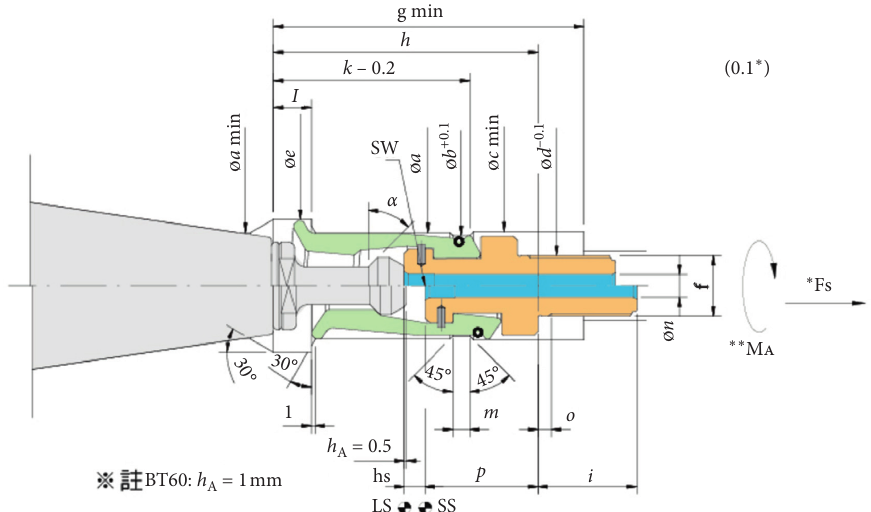
Figure 4: Internal structure size of spindle using